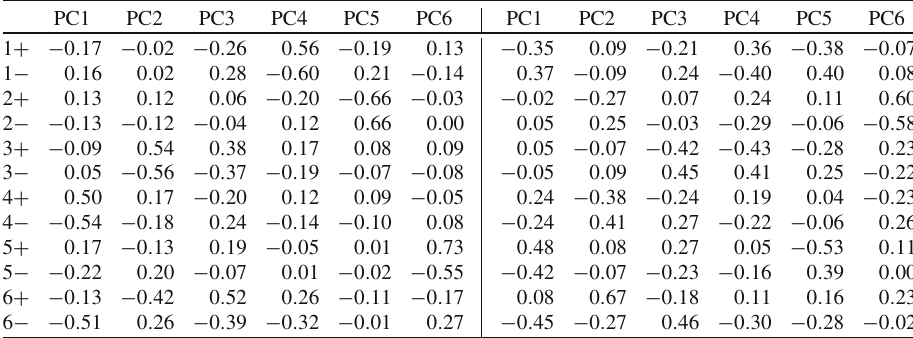
Table 8 Rotation matrix between spaces of δ s and principal components for definition 1 ( δ left)